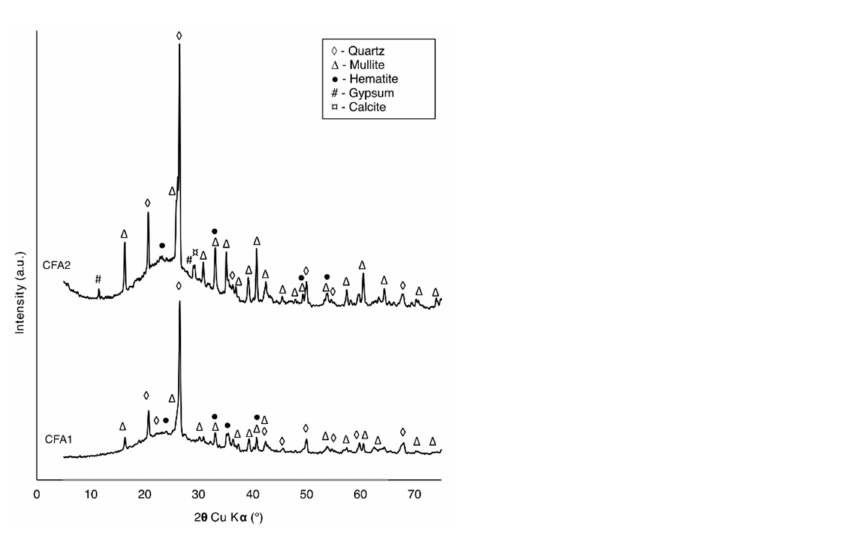
Figure 1. XRD patterns of the first raw coal fly ash (CFA1) and second (CFA2).